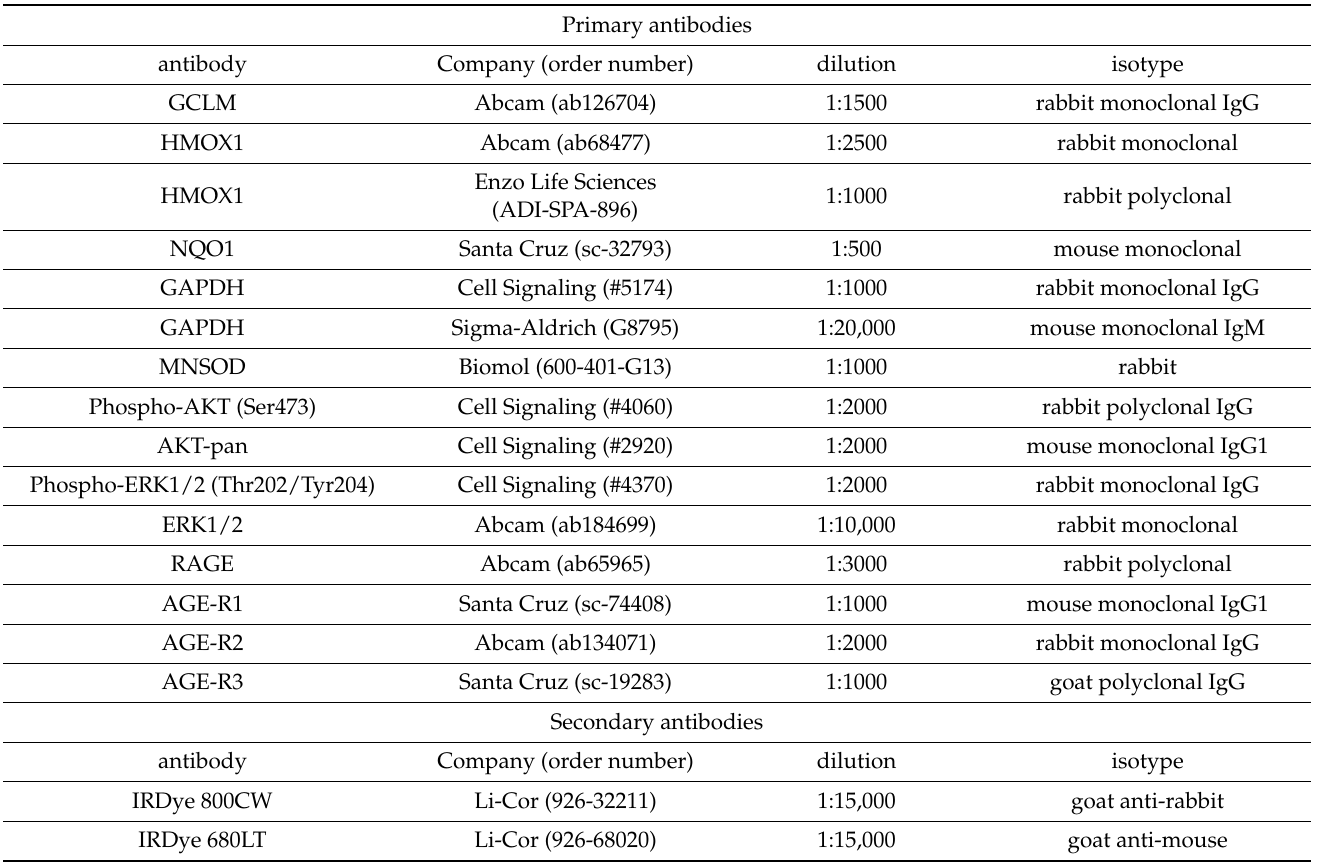
Table A1. Antibodies used for detection of specific proteins.